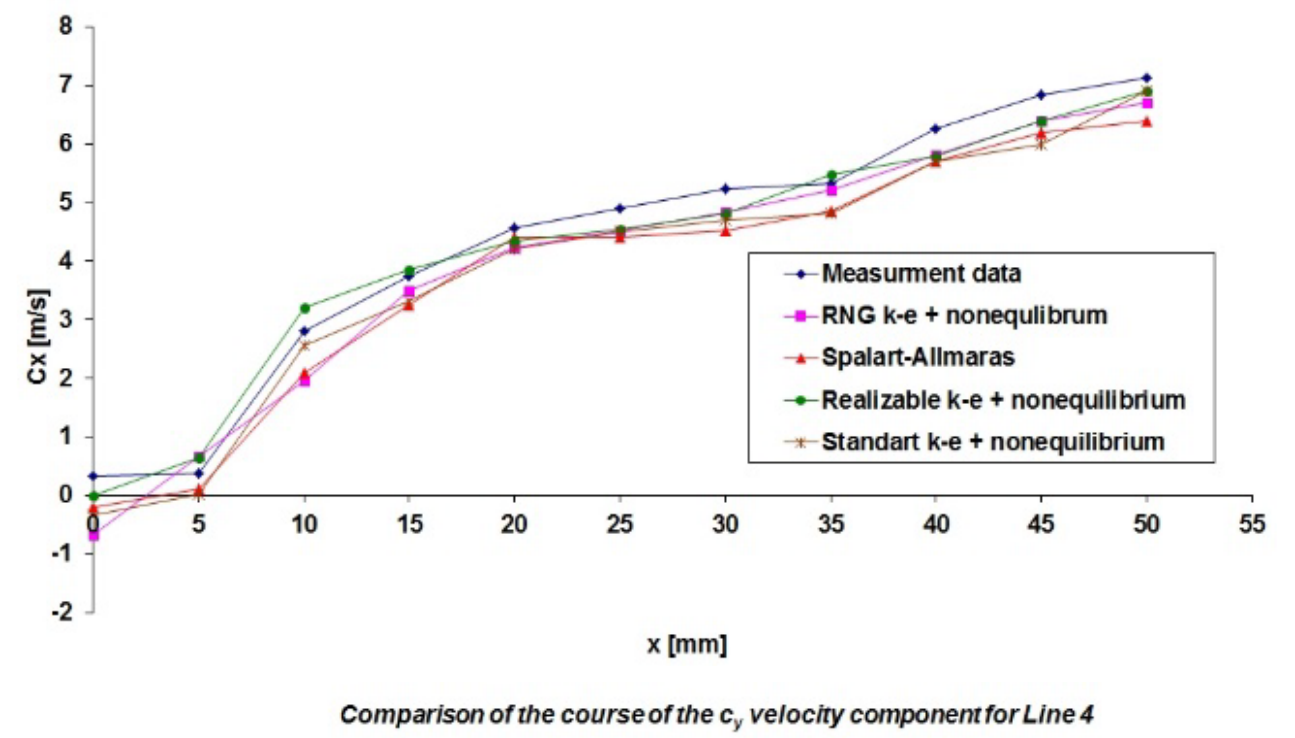
Figure 15. Comparison of the course of the cx, cy velocity components for Line 3.